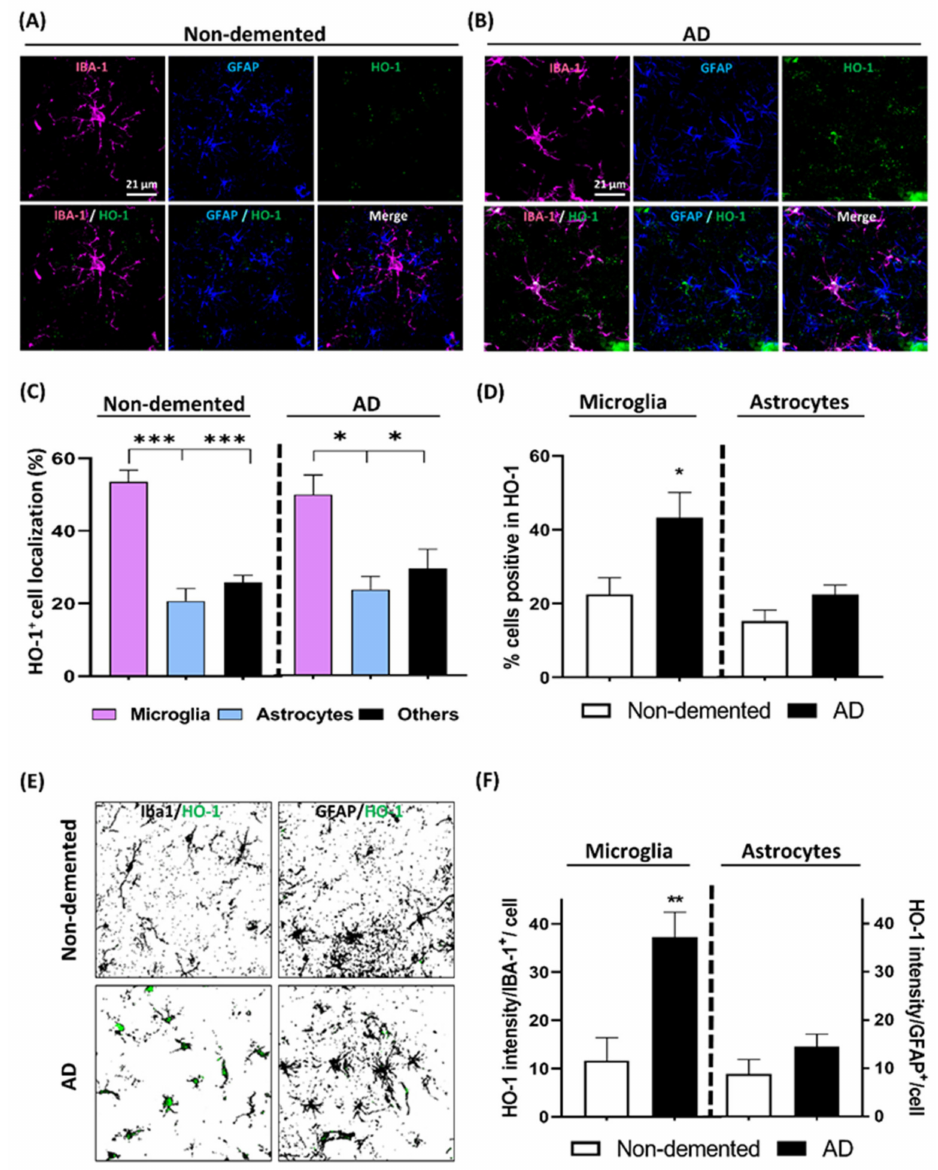
Figure 6. Microglial HO-1 is up-regulated in postmortem human AD cortex samples. Representative confocal images of Iba1 + microglia (magenta) and HO-1 (green) in human cortex samples from non-demented (control) subjects ( A ) and AD patients ( B ). ( C ) Quantification of HO-1 specific localization expressed as percentage, in either microglia, astrocytes or other CNS cell types in non-demented and AD patients. Significant di ff erences were considered when: * p < 0.03 and *** p < 0.001 compared to the percentage of HO-1 + staining in microglia. ( D ) Percentage of total microglia and total astrocytes expressing HO-1 in non-demented (white column) and AD patients (black column). There was a significant increase in the number of microglia cells expressing HO-1 in the AD in comparison to non-demented samples. However, there is no significant di ff erences in total astrocytes containing HO-1 between AD and non-demented patients. ( E ) Representative composite of the percentage of total microglia and astrocytes (black) expressing HO-1 (green). ( F ) Microglial HO-1 expression, measured as HO-1 intensity per Iba1 + cell, was increased in AD samples compared to non-demented controls. However, astroglial HO-1 expression in AD patients was not significantly increased in comparison to non-demented samples. * p < 0.03 and ** p < 0.002 compared to non-demented subjects. Data represent mean ± S.E.M. ( N =